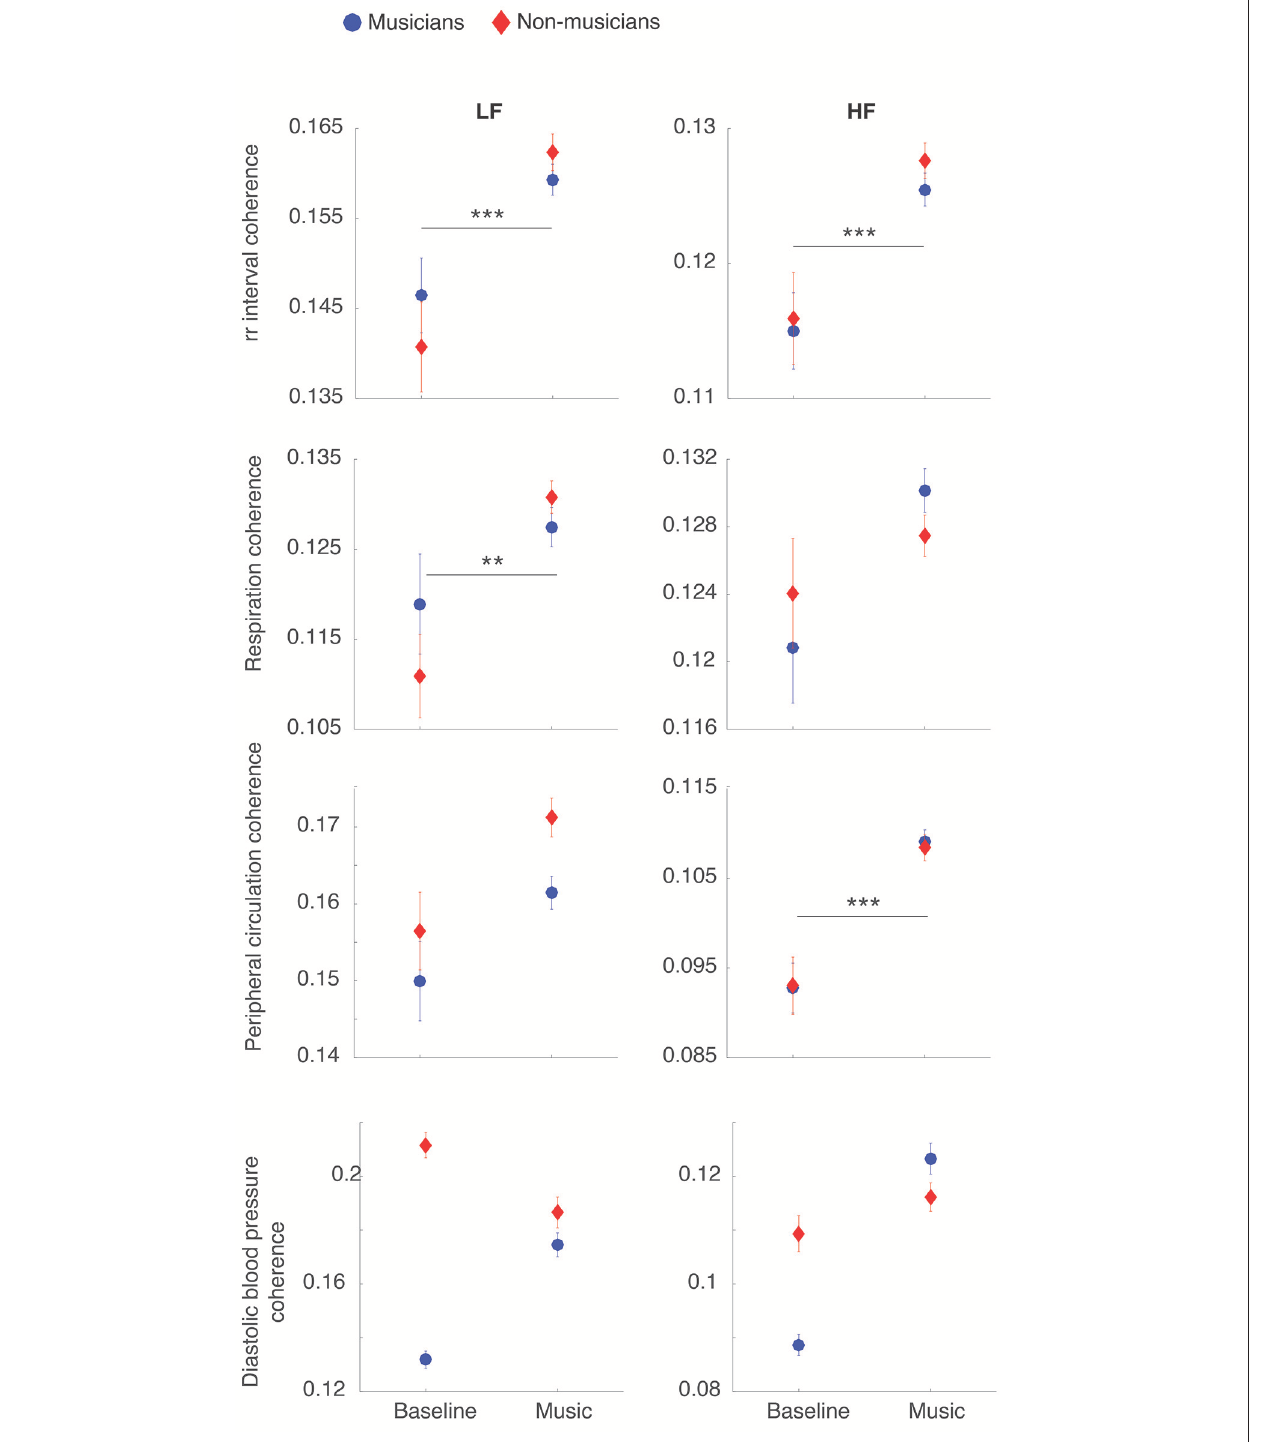
FIGURE 1 | Group synchronization of physiological rhythms increases during passively listening to music. The figure shows the degree of interpersonal synchronization (mean ± SE of coherence scores) during the resting baseline and during passively listening to music. For the purpose of this analysis, the coherence scores from different music excerpts have been averaged together. It can be seen that music results in an increase of interpersonal coherence of heart rate, respiration and peripheral circulation, compared to baseline. ** p < 0.01; *** p < 0.001.